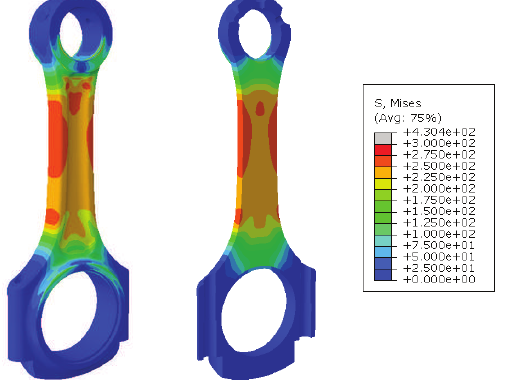
Fig. 20. Results of simulation of connecting rod model 8 Below, all intermediate versions of the connecting rod are shown as solid models.